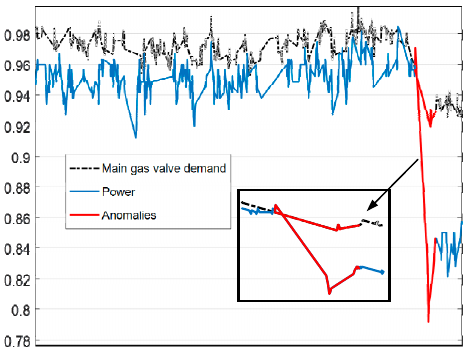
Figure 13. An exemplary anomaly sequence.